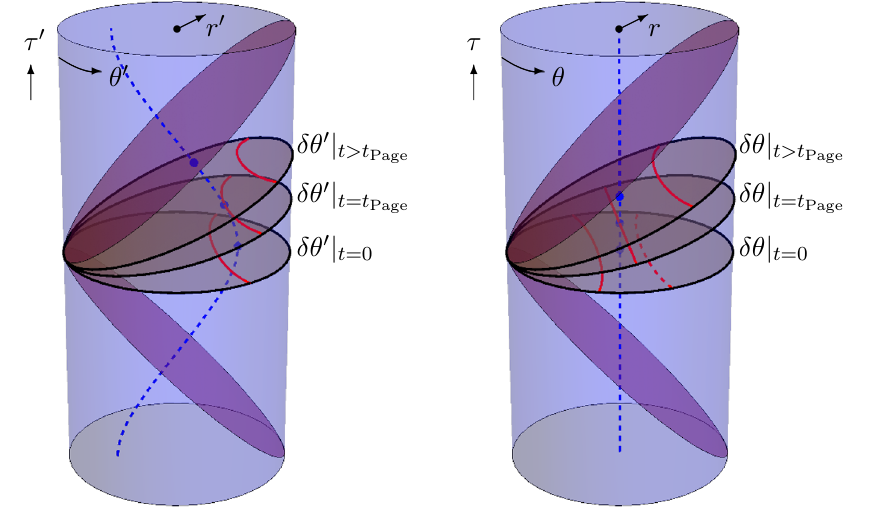
Figure 11 . Evolution of the size of the RT surface (i.e. black brane horizon from the perspective of the Rindler observer) for centered intervals from the point of view of the global frame. Left: we plot the situation as seen from the boosted global coordinates. Right: we plot the situation in the original global frame. In both cases we observe that the size of (cid:13) A (hence the size of the black brane) decreases monotonically as the Poincar(cid:19)e time evolves from t = 0 to t ! 1 . This implies that, for centered intervals, our setup can indeed be interpreted as a toy model of black hole evaporation. We remark that (cid:14)S ( (cid:14)(cid:26) ) indeed behaves as a Page bulk curve for t 2 [0 ; 1 ], reaching a peak at t = t Page and then decreasing as the state evolves in time. In